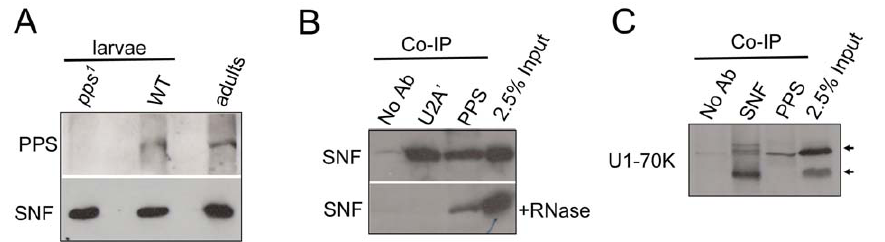
Figure 4. PPS associates with SNF and U1-70K in embryonic extracts. (A) pps 1 is a protein-null allele. Western blot of extracts made from wild type and pps 1 mutant animals probed with antibodies against PPS. SNF is used here as a loading control. (B) PPS interacts with SNF in a RNA– independent manner. Western blots of PPS and U2A’ immunoprecipitations (Co-IP) in nuclear extracts made from embryos probed with an antibody against SNF. The RNase sensitivity of this association was tested by pretreating the extract with a combination of RNase A and RNase T1. Controls include the previously described RNase sensitive SNF/U2A’ association. (C) PPS associates with U1-70K. Western blot of PPS and SNF immunoprecipitations (Co-IP) in nuclear extracts made from embryos probed with an antibody against U1-70K. Controls include the previously described SNF/U1-70K association. The lanes marked 2.5% input are controls in which the amount of extract corresponds to 2.5% of the material used in each Co-IP experiment.